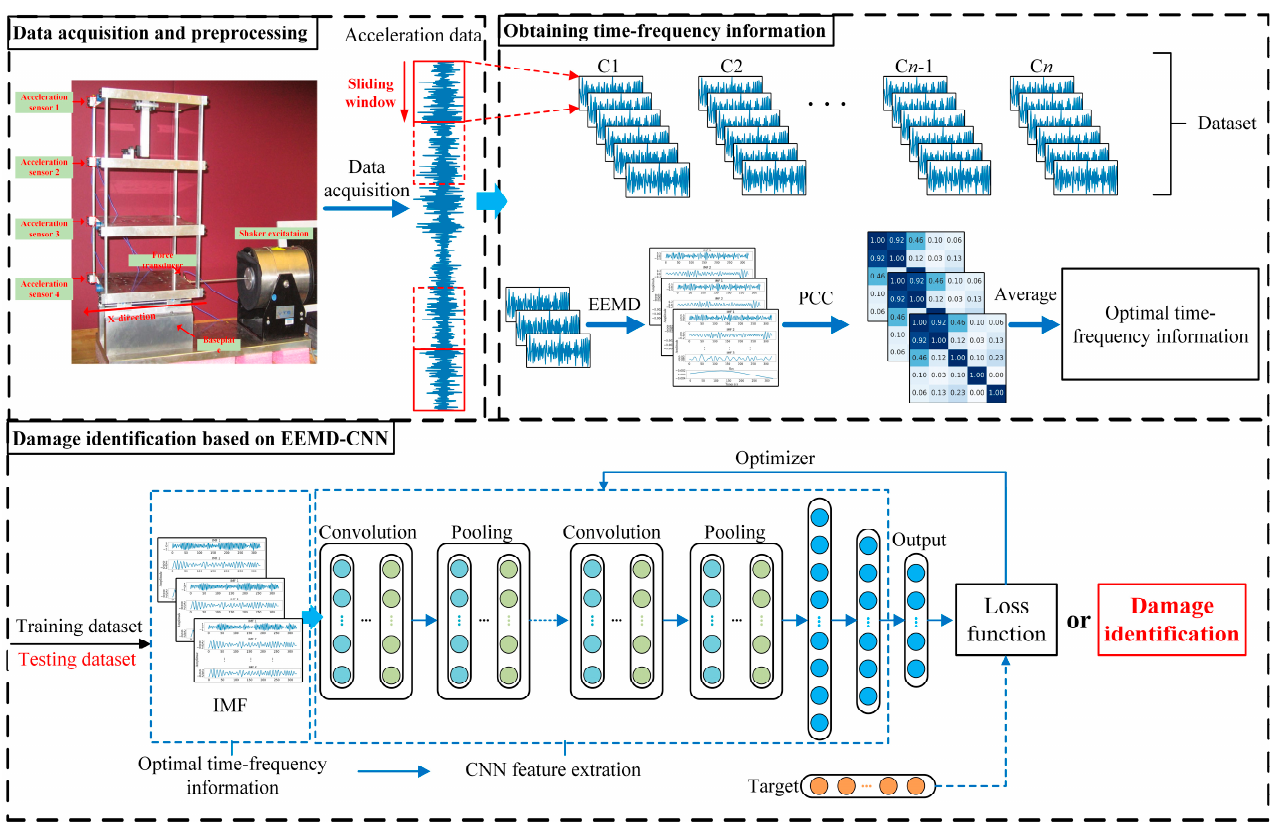
Figure 1. A hybrid deep learning framework for damage identification based on EEMD-PCC-CNN.